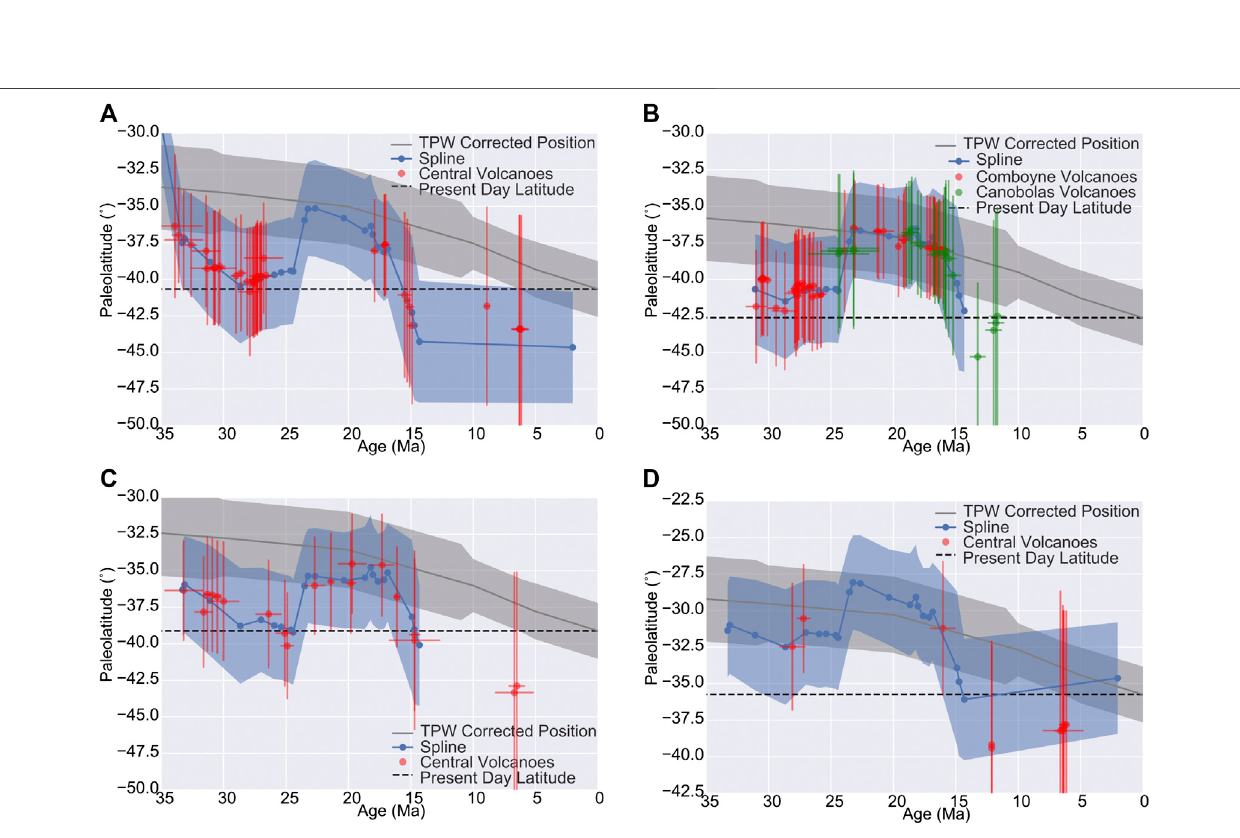
Frontiers in Earth Science |